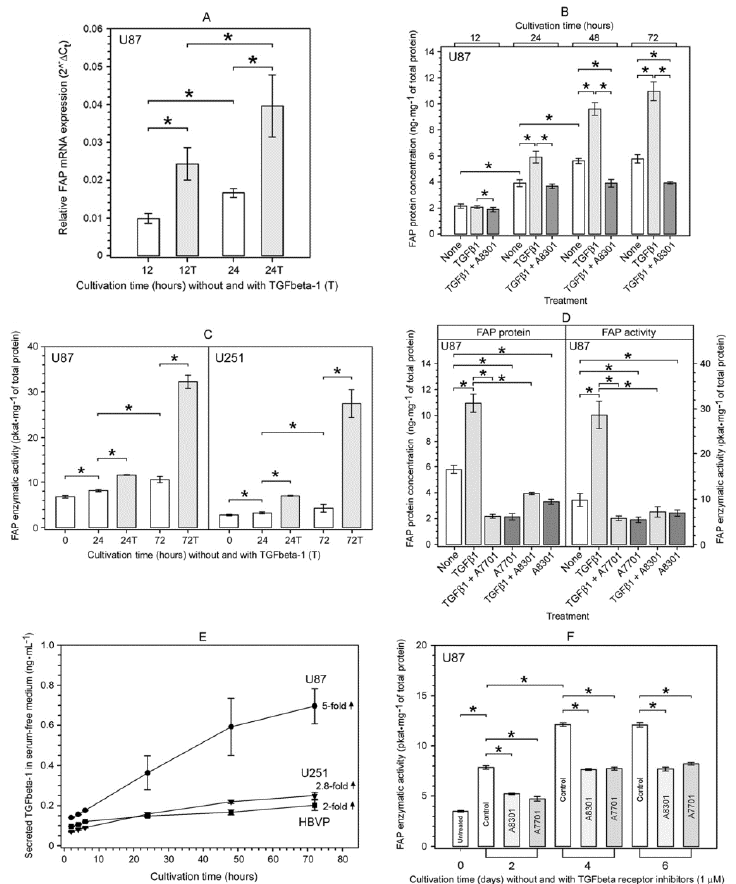
Figure 6. Characterization of TGFbeta-1-mediated upregulation of FAP mRNA, FAP protein, and FAP enzymatic activity in human glioma cells. ( A ) Time-dependent upregulation of FAP mRNA expression in U87 glioma cells during cultivation without and with 10 ng ⋅ mL − 1 of human recombinant TGFbeta-1. ( B ) Time-dependent upregulation of FAP protein in U87 glioma cells during cultivation without and with 10 ng ⋅ mL − 1 of human recombinant TGFbeta-1. A complete blocking of exogenous and partial blocking of endogenous FAP protein upregulation by co-treatment with the TGFbeta type I receptor inhibitor A8301 (1 µM). ( C ) Time-dependent upregulation of FAP enzymatic activity in U87 and U251 glioma cells during cultivation without and with 10 ng ⋅ mL − 1 of human recombinant TGFbeta-1. ( D ) Upregulation of both FAP protein and FAP enzymatic activity in U87 glioma cells after cultivation with 10 ng ⋅ mL − 1 of human recombinant TGFbeta-1 for 72 h and its complete blocking by co-treatment with the TGFbeta type I receptor inhibitors A7701 and A8301 (both at 1 µM), which also reduced the baseline FAP protein and FAP enzymatic activity levels. ( E ) Time course of secretion of endogenous TGFbeta-1 into serum-free media by cultured glioma cells U87 and U251 and human brain vascular pericytes (HBVP). The mean increase in secreted TGFbeta-1 level between the 2nd and 72nd hour of cultivation is indicated for each examined cell line. ( F ) Time course of increase in the baseline level of FAP enzymatic activity in cultured U87 glioma cells and its marked decrease by treatment with A8301 and A7701 (both at 1 µM). The results in (A) are presented as the mean ± SD from three parallel cell cultures measured in triplicate. Results in ( B – F ) are presented as the mean ± SD from five or six parallel cell cultures measured in triplicate. In A, * p < 0.05, one way repeated measures ANOVA. In ( B , C , F ), * p < 0.05, Friedman repeated measures ANOVA on ranks. In ( D ), * p < 0.05, one way ANOVA, Tukey’s post hoc test.